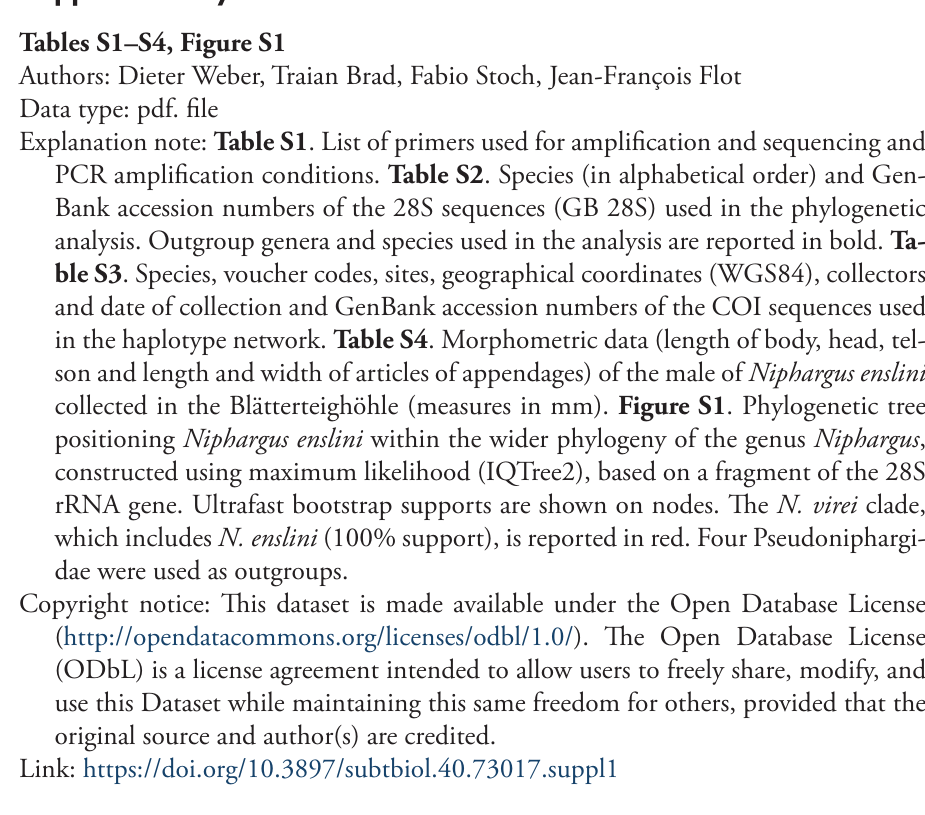
Explanation note: Table S1 . List of primers used for amplification and sequencing and PCR amplification conditions. Table S2 . Species (in alphabetical order) and Gen- Bank accession numbers of the 28S sequences (GB 28S) used in the phylogenetic analysis. Outgroup genera and species used in the analysis are reported in bold. Ta- ble S3 . Species, voucher codes, sites, geographical coordinates (WGS84), collectors and date of collection and GenBank accession numbers of the COI sequences used in the haplotype network. Table S4 . Morphometric data (length of body, head, tel- son and length and width of articles of appendages) of the male of Niphargus enslini collected in the Blätterteighöhle (measures in mm). Figure S1 . Phylogenetic